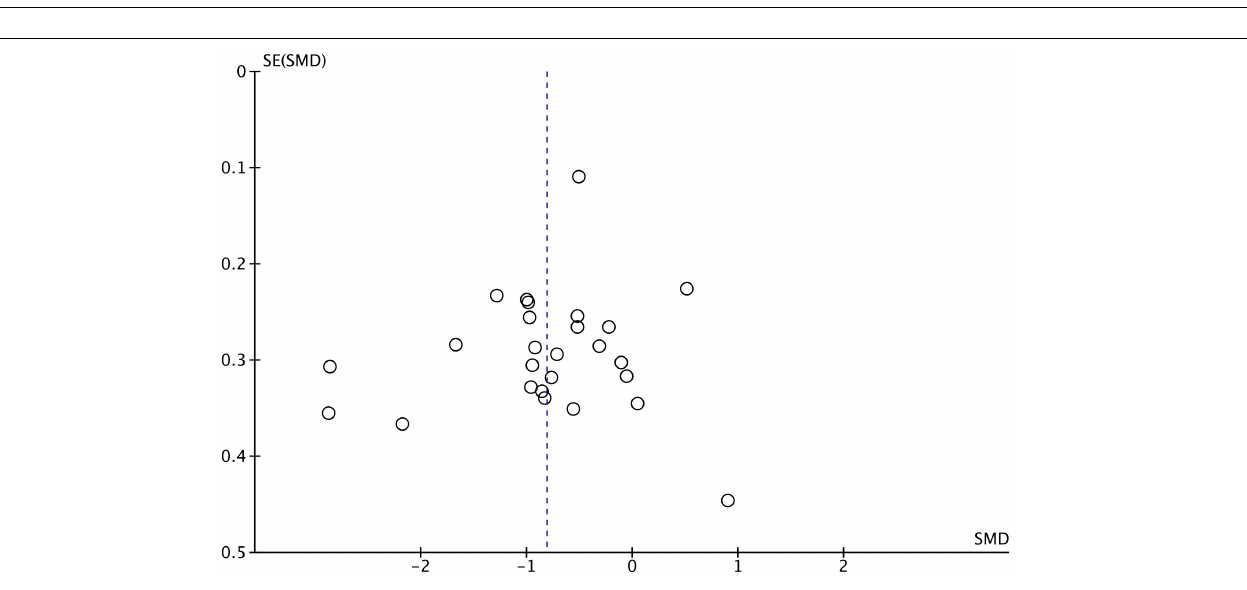
FIGURE 2 | Funnel plot for 11 studies comparing Central Coherence performance between ASD and TD. SMD, standard mean difference (effect size); SE, standard error. Positive effect sizes indicate superior performance in ASD. The solid vertical line indicates the estimate for the population effect size.